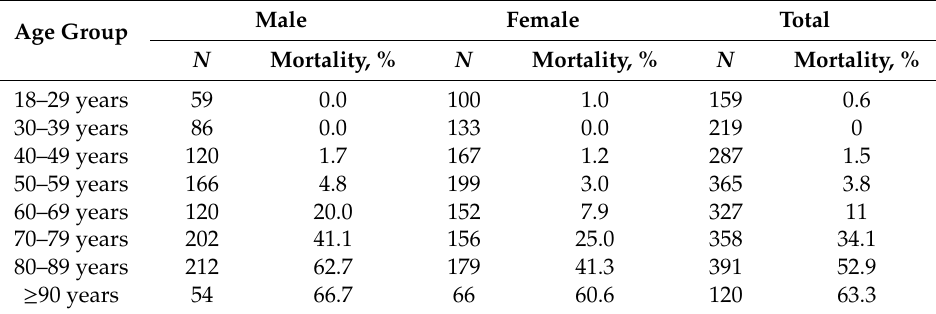
Table 3. Mortality distribution by age group and